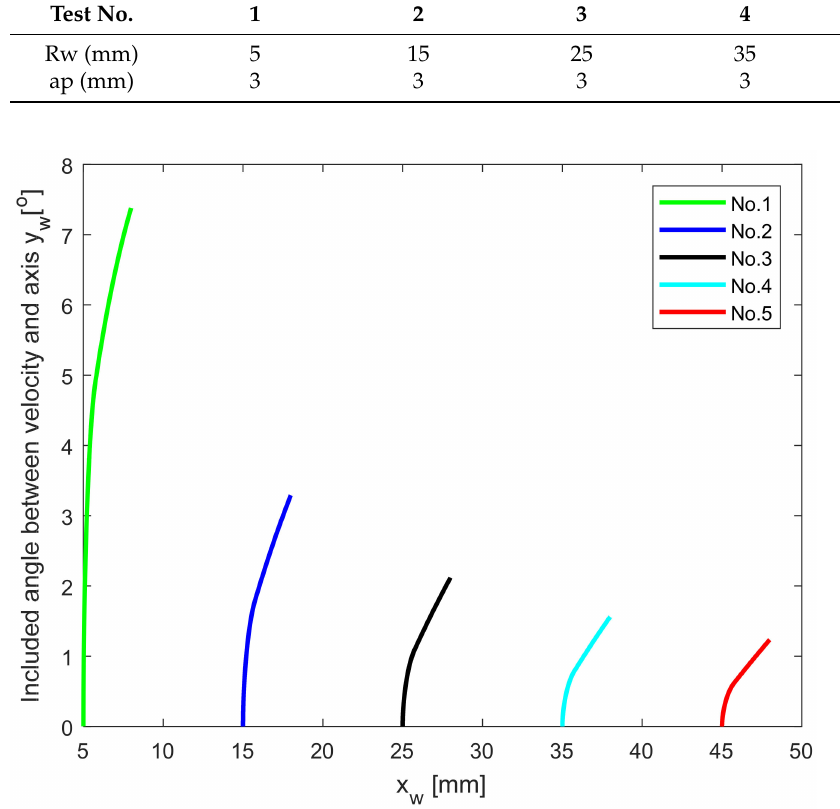
Figure 6. Included angle between velocity and y w axis for different workpiece